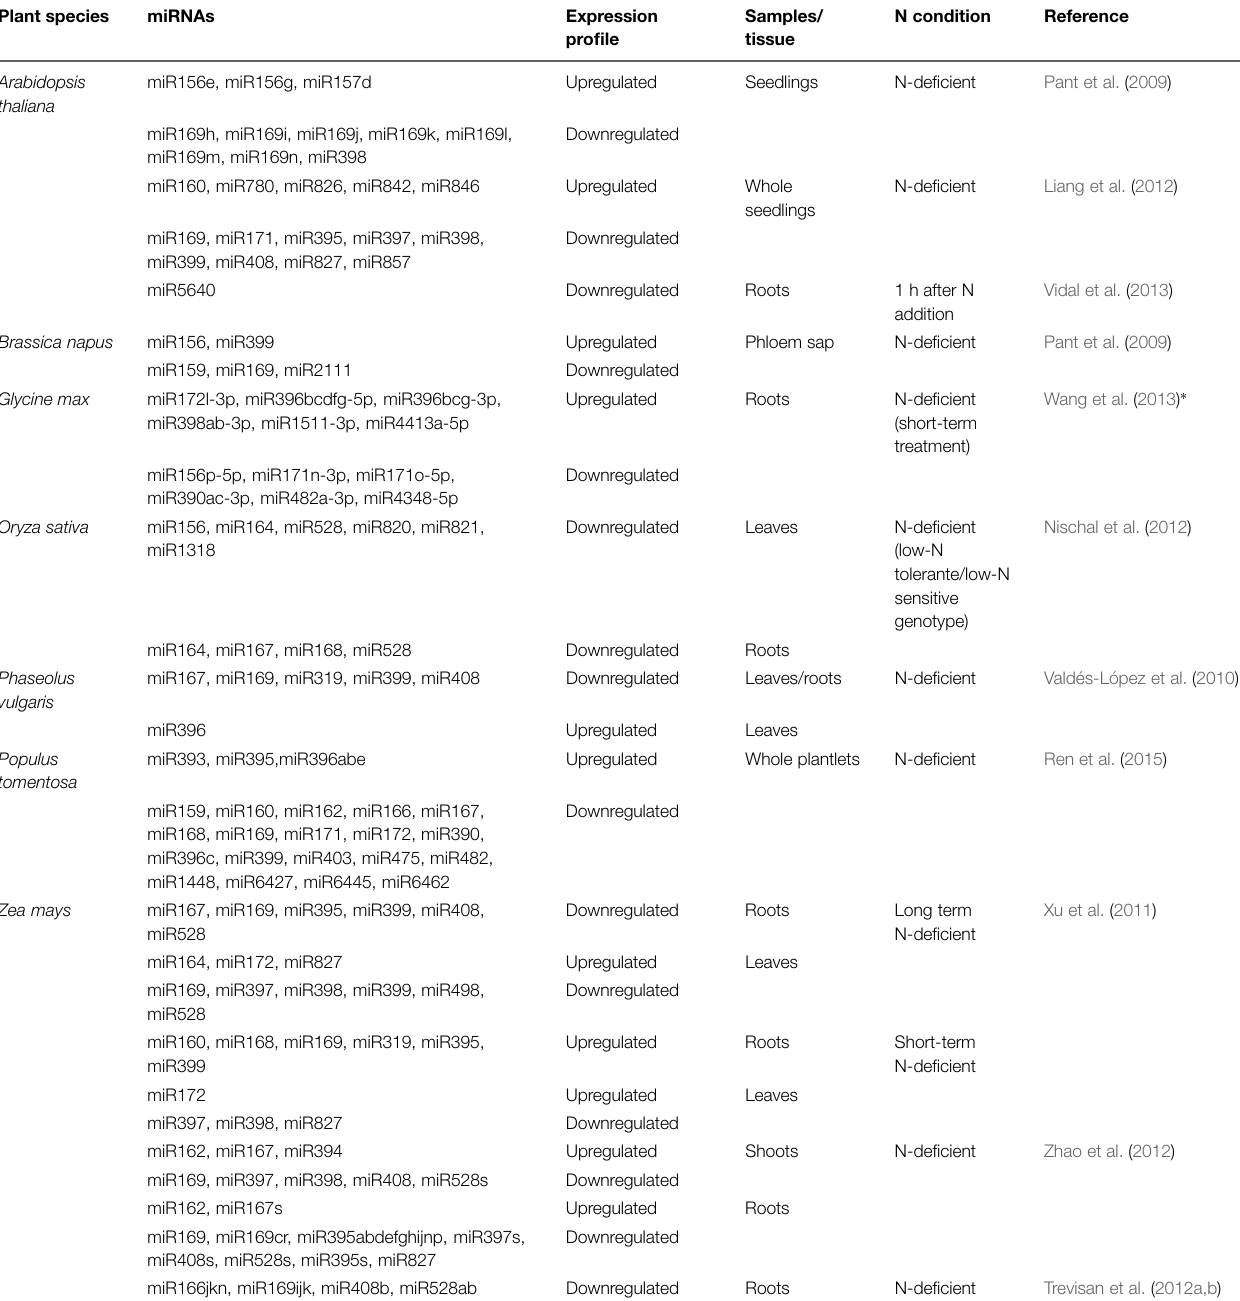
TABLE 1 | N-responsive miRNAs with respective expression profiles according to different treatments, tissues, and